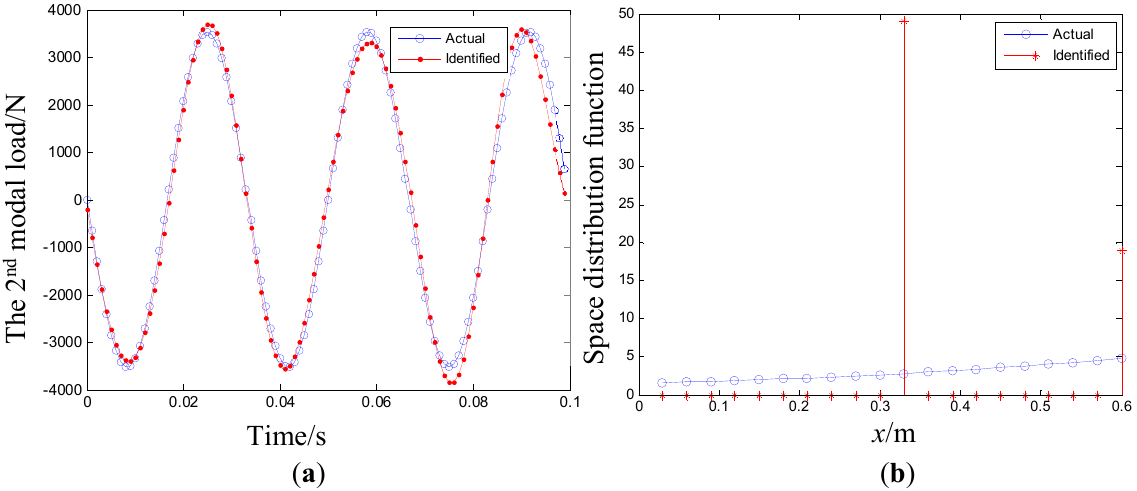
Load spatial distribution. Figure 6. Equivalent sparse identification of the load median function. ( a ) Load time history. ( b ) Load